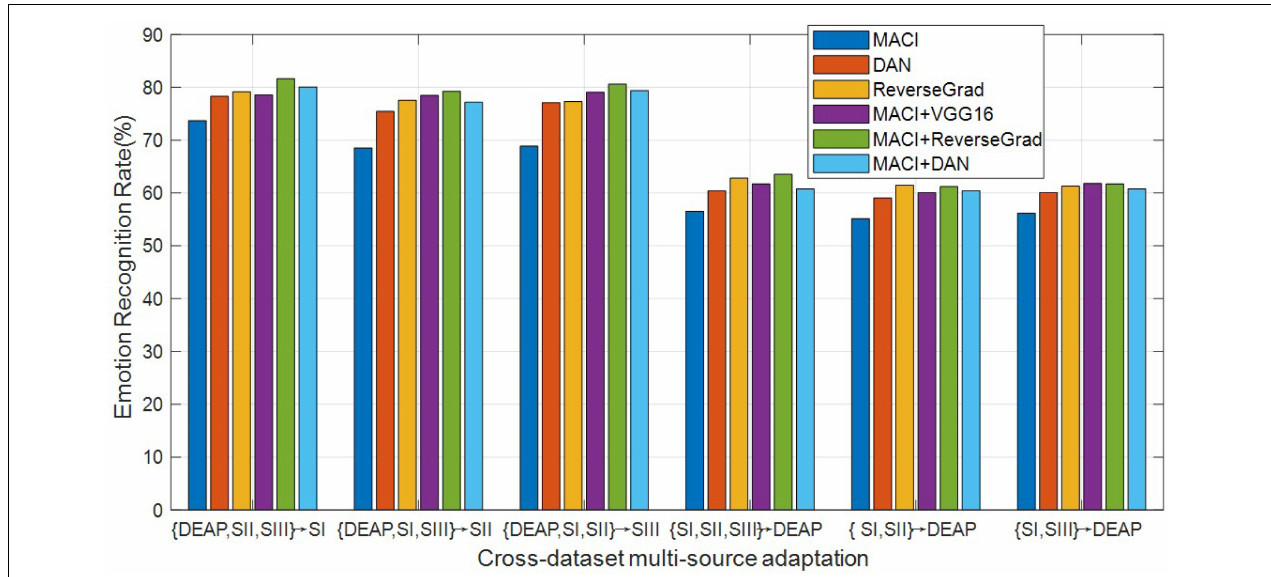
FIGURE 4 | Emotion recognition accuracies (%) of different methods using deeply extracted features (SI, session I; SII: session II; SIII, session